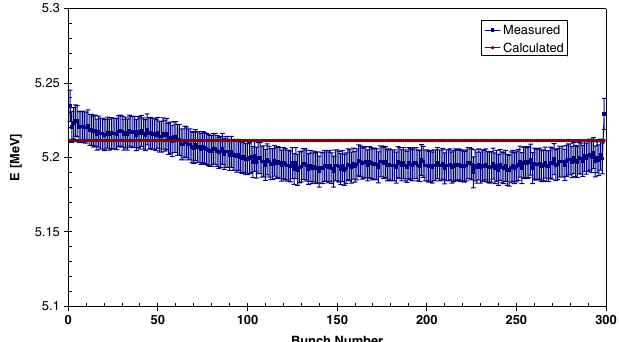
FIG. 13. 300 bunches, total charge generation of 160 nC, and comparison with calculation.